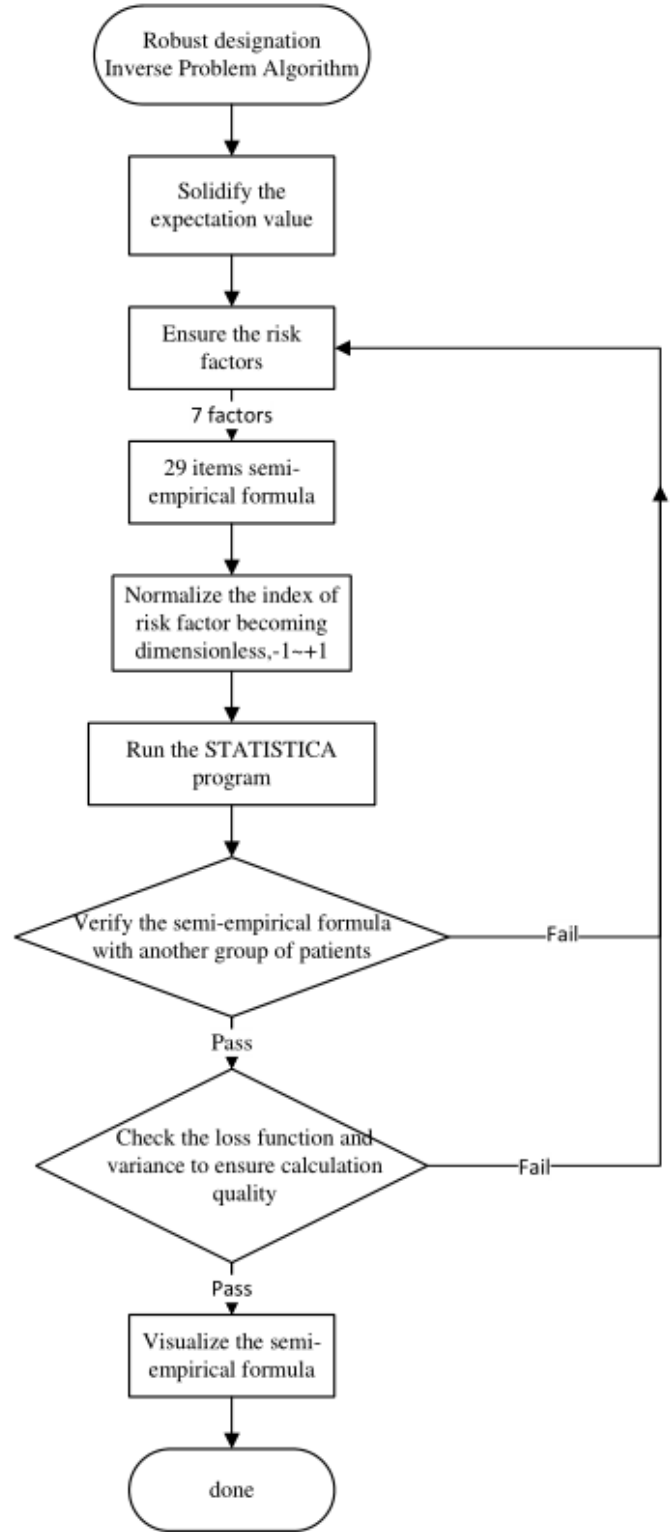
Figure 2. The flowchart of specific workloads illustrates how researchers apply the IPA technique in artificial intelligence. artificial